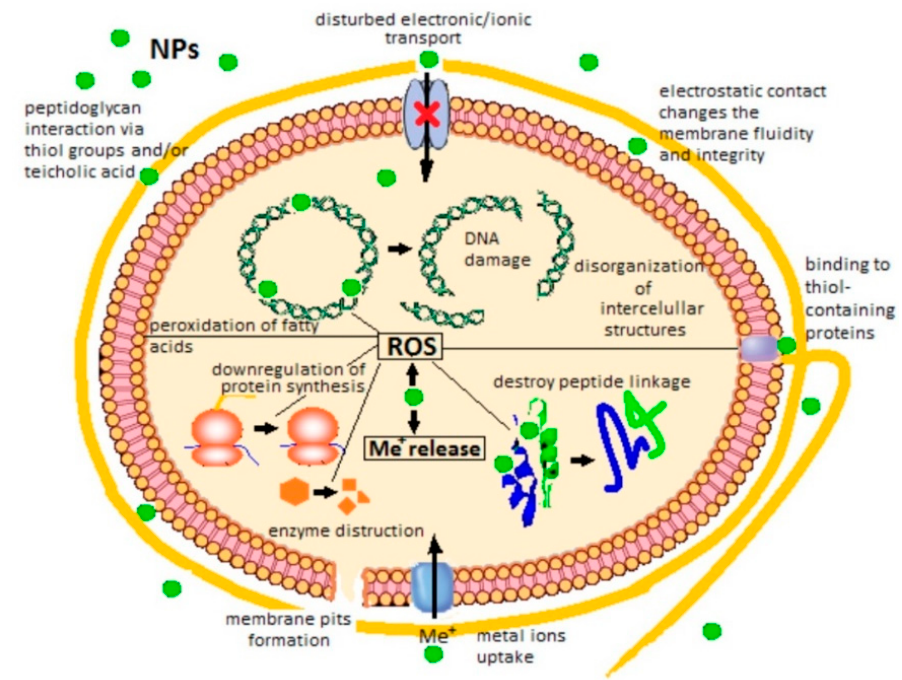
Figure 7. Mechanisms of bacteria cell damage by MONPs, illustrating the possible MONP interactions with the bacterial cell wall, membrane components, DNA, enzymes and other proteins and the influence of external ROS on membrane integrity, protein synthesis and functioning. Different MONPs may cause toxicity via one or more of the described mechanisms.